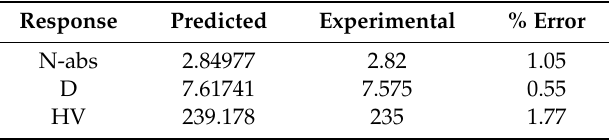
Table 15. Experimental validation of the